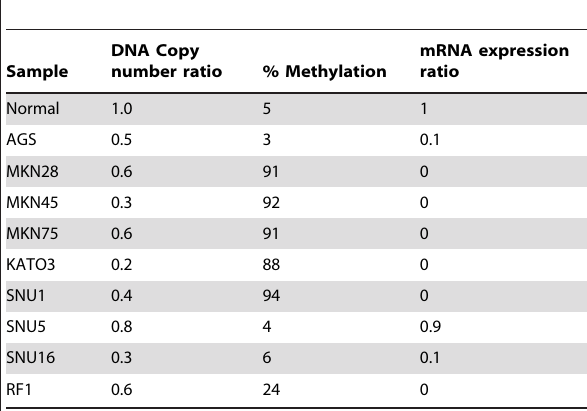
Table 1. DNA copy number, methylation level and gene expression of GPX3 in gastric cancer cell